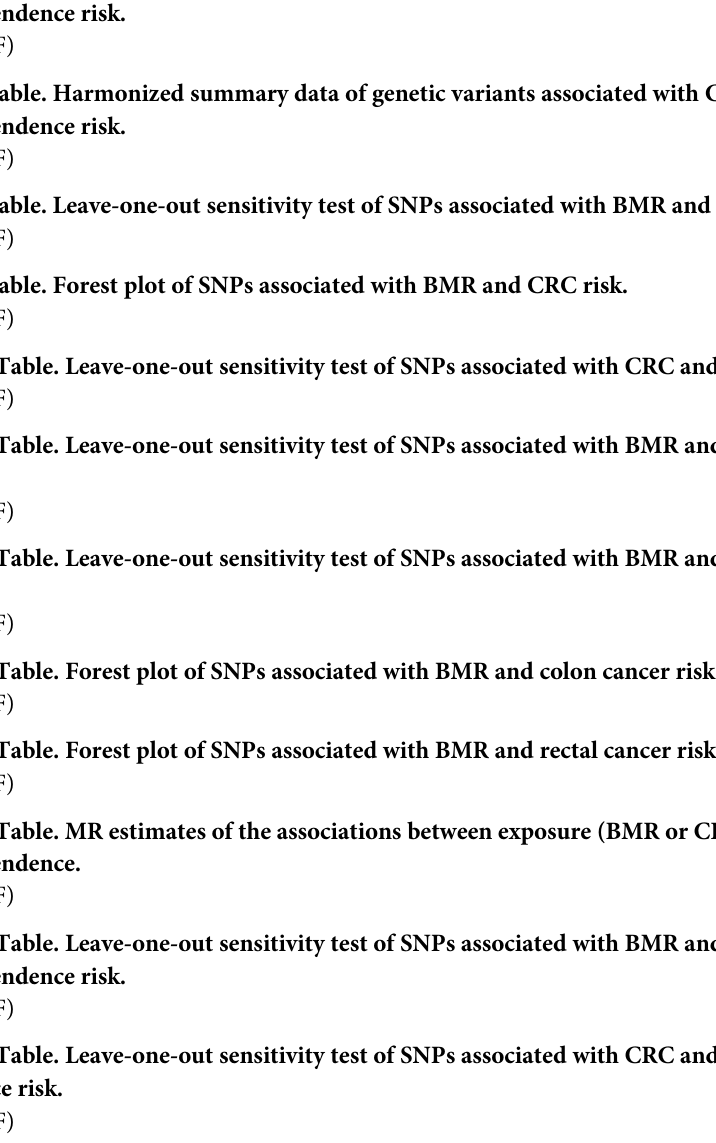
S3 Table. Harmonized summary data of genetic variants associated with BMR on colon cancer risk. (PDF) S4 Table. Harmonized summary data of genetic variants associated with BMR on rectal cancer risk. (PDF) S5 Table. Harmonized summary data of genetic variants associated with CRC on BMR risk. (PDF) S6 Table. Harmonized summary data of genetic variants associated with BMR on smoking dependence risk. (PDF) S7 Table. Harmonized summary data of genetic variants associated with CRC on smoking dependence risk. (PDF) S8 Table. Leave-one-out sensitivity test of SNPs associated with BMR and CRC risk. (PDF) S9 Table. Forest plot of SNPs associated with BMR and CRC risk. (PDF) S10 Table. Leave-one-out sensitivity test of SNPs associated with CRC and BMR risk. (PDF) S11 Table. Leave-one-out sensitivity test of SNPs associated with BMR and colon cancer risk. (PDF) S12 Table. Leave-one-out sensitivity test of SNPs associated with BMR and rectal cancer risk. (PDF) S13 Table. Forest plot of SNPs associated with BMR and colon cancer risk. (PDF) S14 Table. Forest plot of SNPs associated with BMR and rectal cancer risk. (PDF) S15 Table. MR estimates of the associations between exposure (BMR or CRC) and smoking dependence. (PDF) S16 Table. Leave-one-out sensitivity test of SNPs associated with BMR and smoking dependence risk. (PDF) S17 Table. Leave-one-out sensitivity test of SNPs associated with CRC and smoking depen- dence risk.